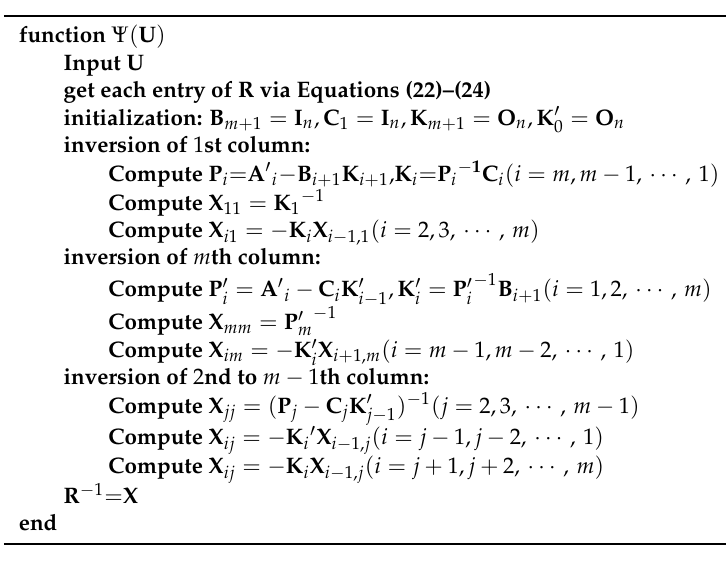
Table 2. Fast Computation of R − 1